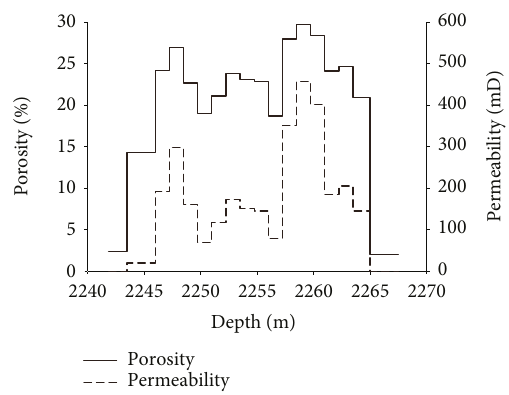
Figure 4: Porosity and permeability of the reservoir